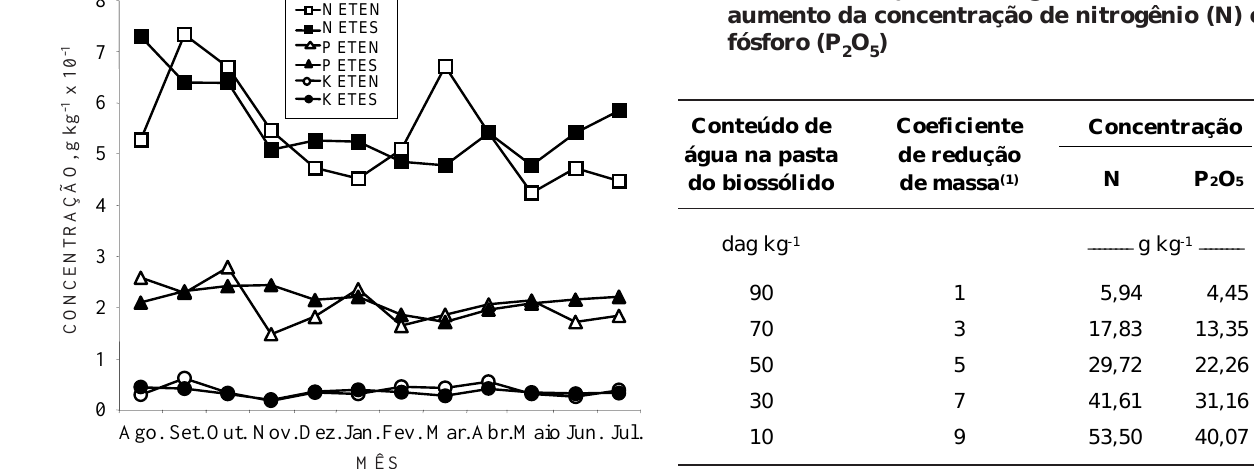
(1) Valor pelo qual se deve dividir a massa do biossólido a 90 dag kg -1 para obter a massa correspondente após a secagem a um novo conteúdo de